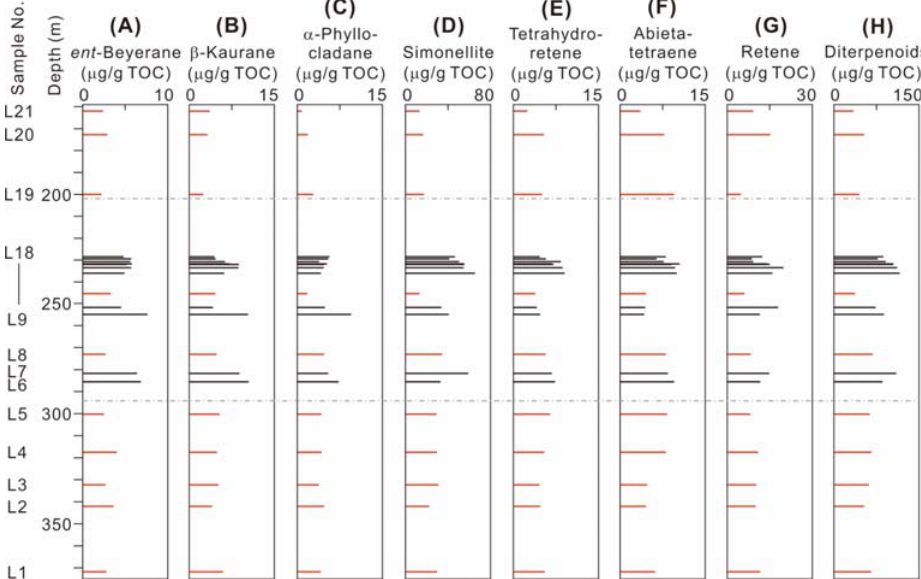
Figure 11. Diterpenoids in saturated and aromatic hydrocarbon fractions of oil shale and coal. ( A ) ent -Beyerane. ( B ) b-Kaurane. ( C ) a-Phyllocladane. ( D ) Simonellite. ( E ) Tetrahydro-retene. ( F ) Abieta-tetraene. ( G ) Retene. ( H ) Total diterpenoid concentration. The red bar represents oil shale, and the black bar represents coal. The two horizontal grey lines show the boundaries of the three units.